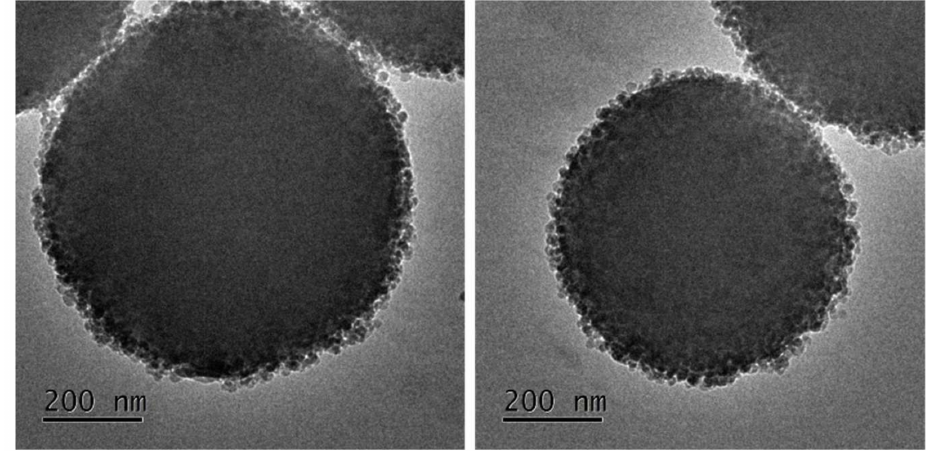
Figure 4. TEM images of St-co-DVB microspheres obtained at 1 wt% DVB.